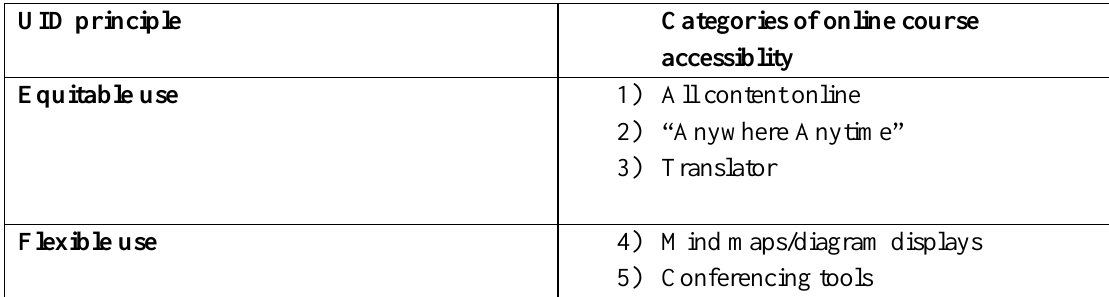
Universal Instructional Design Principles and Categories of Online Course